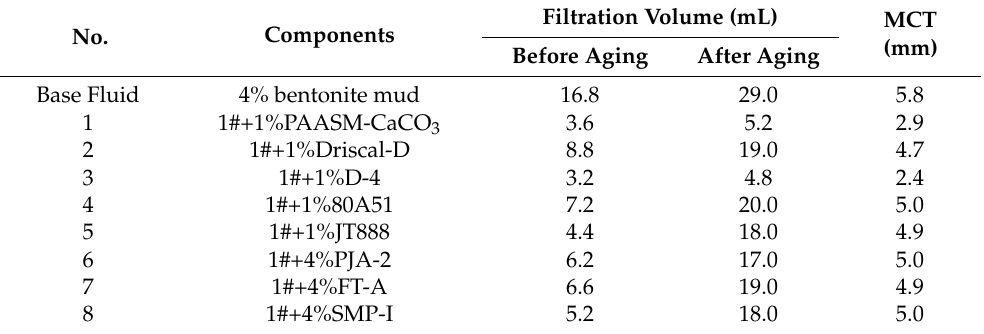
Table 5. Comparison of filtration control effects after aging (200 °C/16 h) of common filtration reducers.